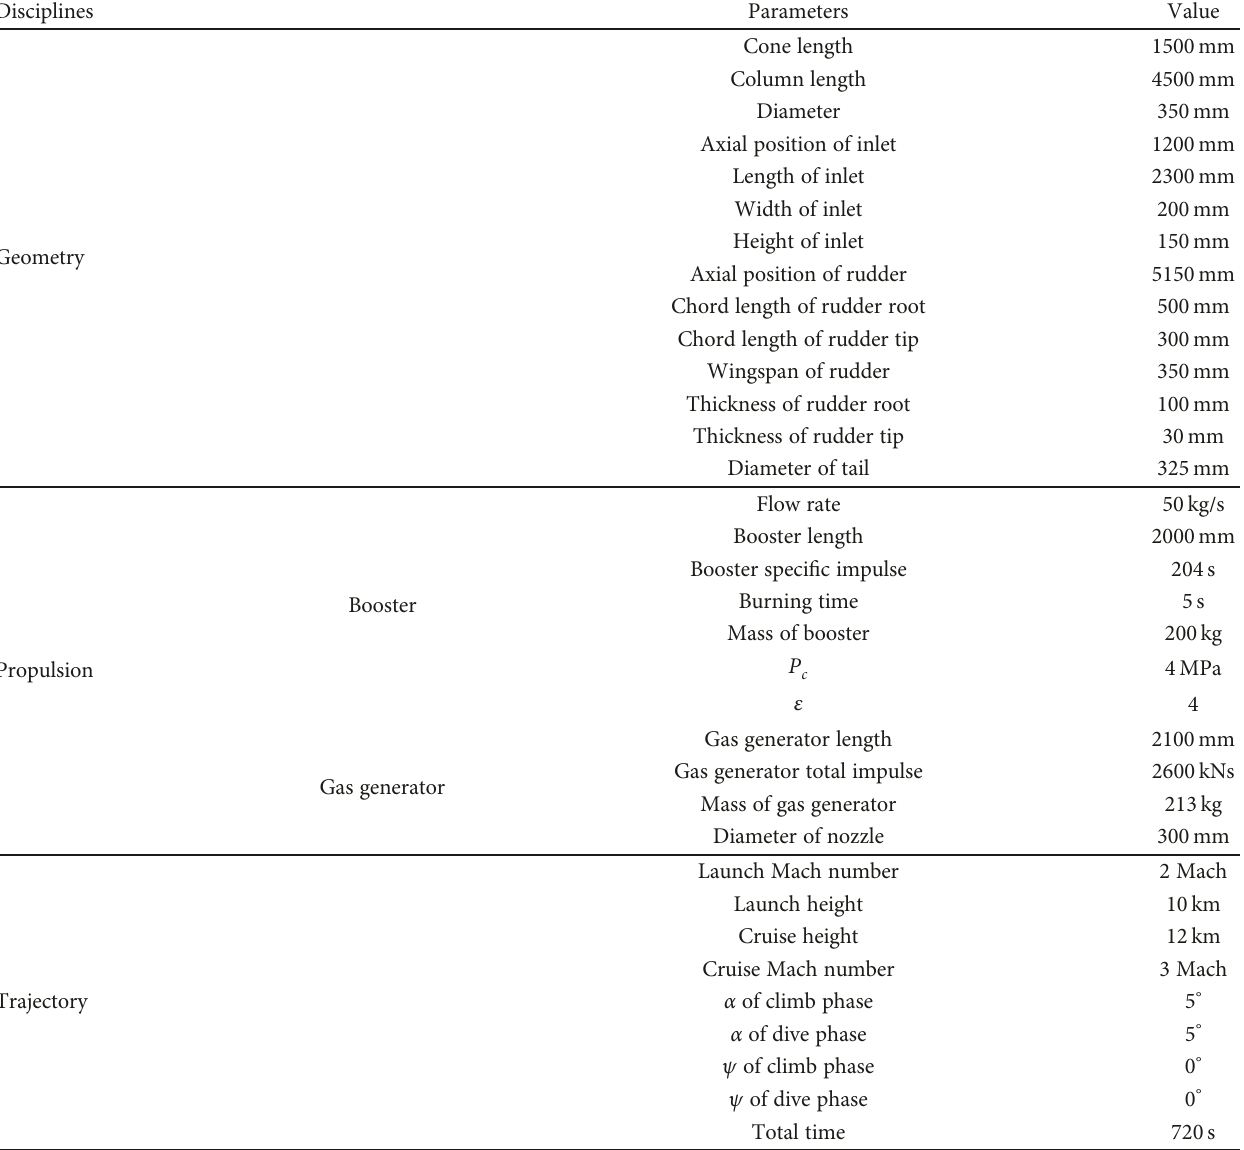
Table 8: All input